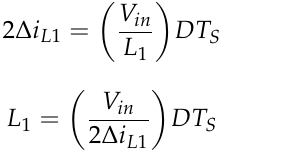
Figure 7. The inductor L 1 current.